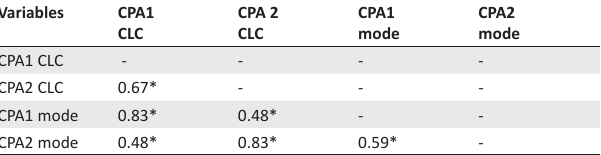
Correlations: Table 3 shows that in terms of the first CPA